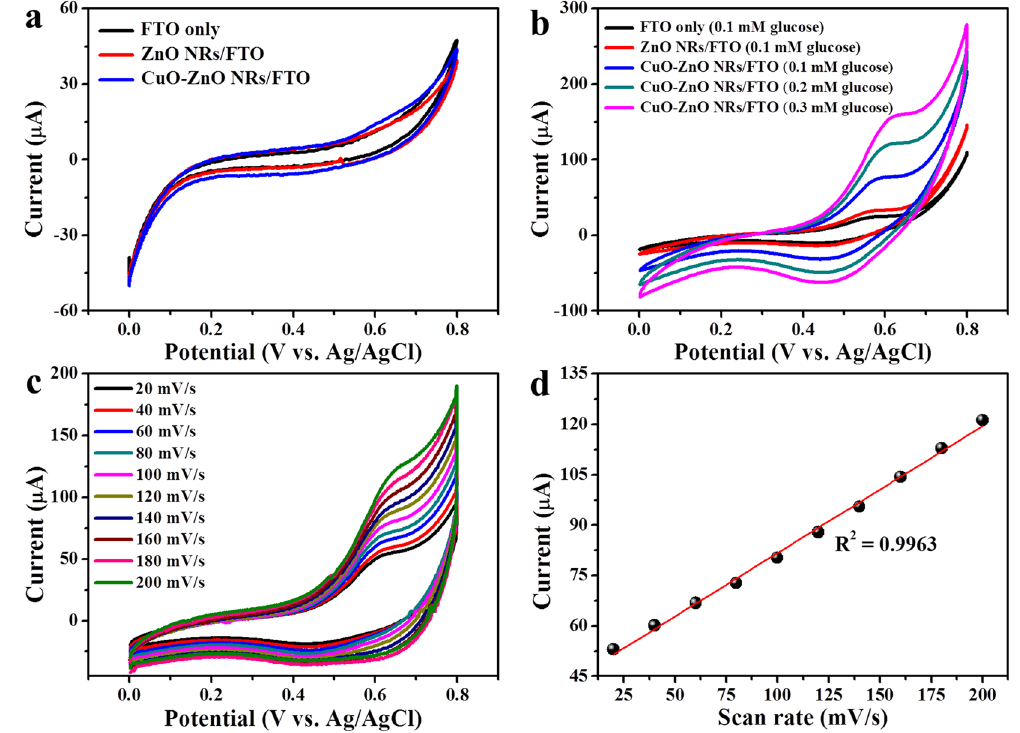
Figure 5. Typical CV curve of electrodes. ( a ) CV response of FTO, ZnO NRs/FTO, and CuO-ZnO NRs/ FTO electrodes in blank NaOH solution (scan rat, 100 mVs − 1 ). ( b ) CVs in the presence of glucose at different electrode (scan rat, 100 mVs − 1 ). ( c ) CVs for CuO-ZnO NRs/FTO in 0.1 mM glucose at scan rats from 20 to 200 mVs − 1 . ( d ) Corresponding calibration plot of peak current versus scan